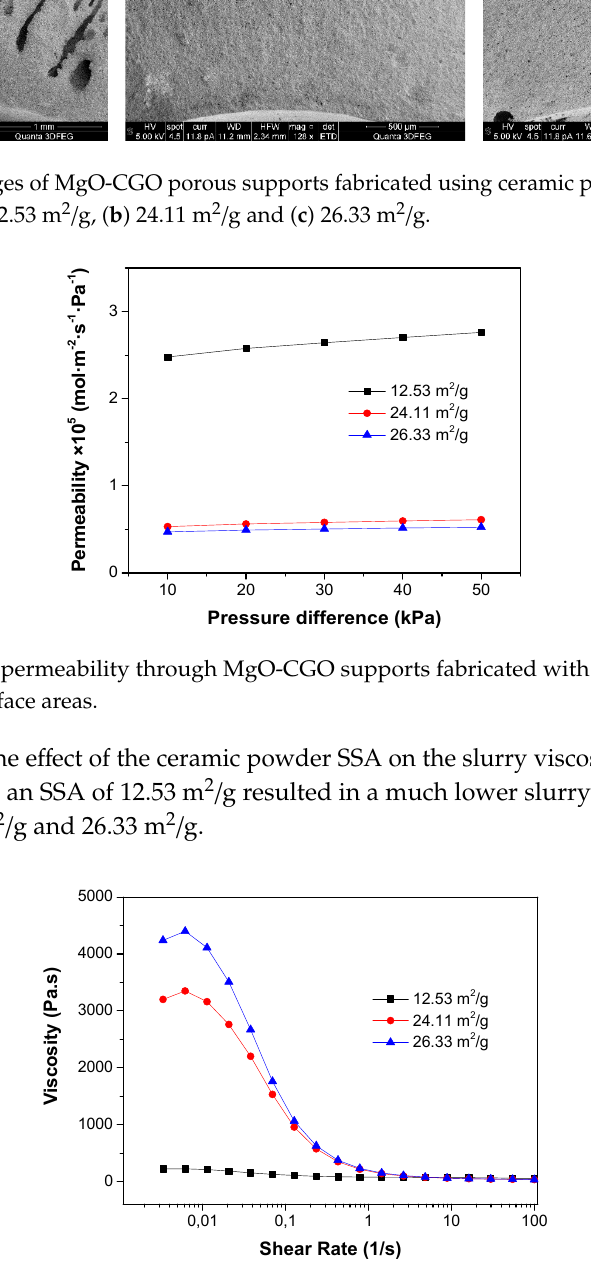
Figure 14. Rheological behaviour of the slurries prepared with ceramic powders of different specific surface areas.